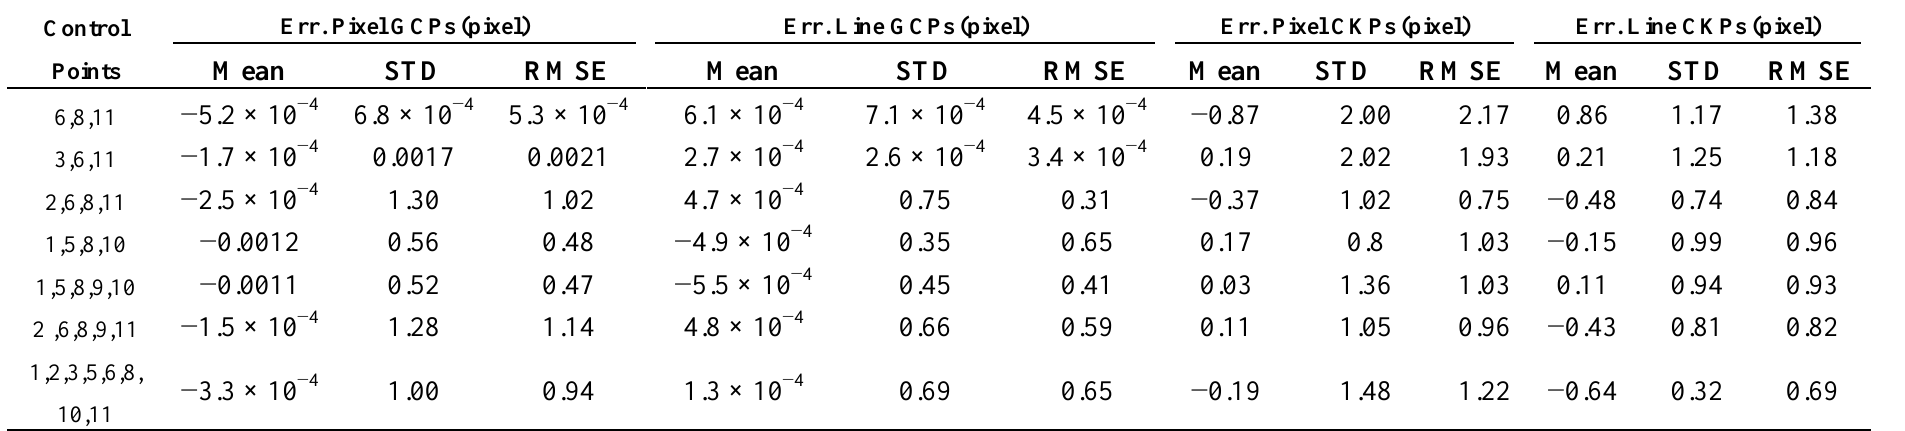
Table 4. The results of rational polynomial coefficient (RPC) refinement using the affine model in different ground control point (GCP) scenarios. The locations of the points in column 1 are shown in Figure 2. CKP: check point, STD: standard deviation, RMSE: root mean square